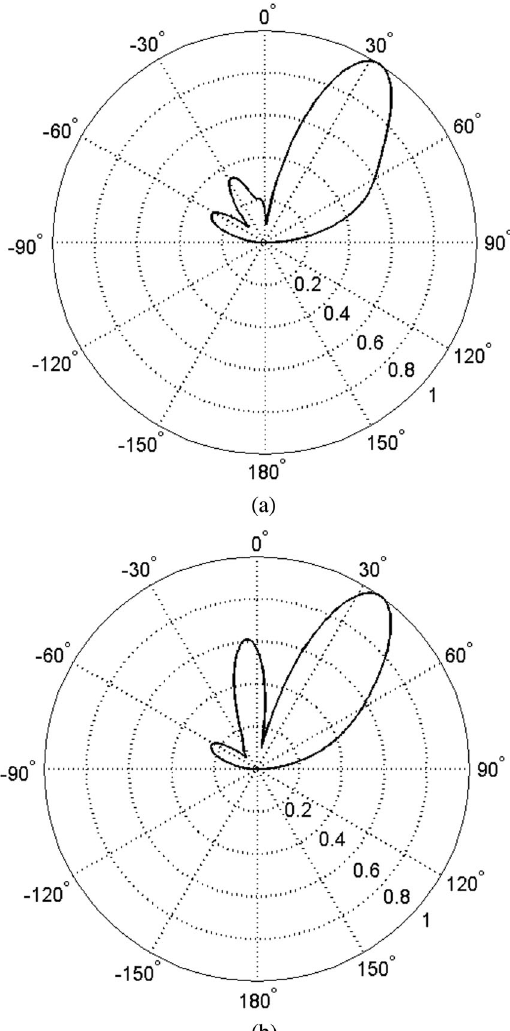
FIG. 10. Radiation patterns of (a) Dolph-Tschebyscheff and (b) uniform arrays. Both arrays redirect the normally incident plane wave at